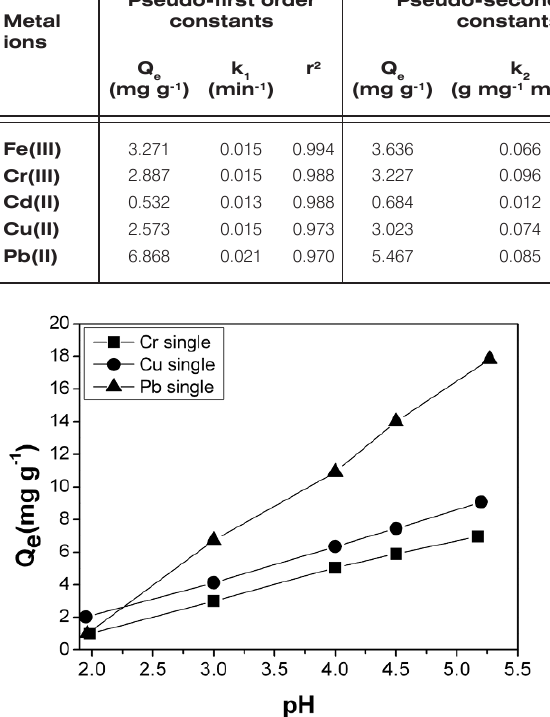
Table 1. Kinetic parameters of adsorption of Fe(III), Cr(III), Cd(II), Cu(II) and Pb(II) ions from multi-component aqueous solutions onto Si-10Al Metal